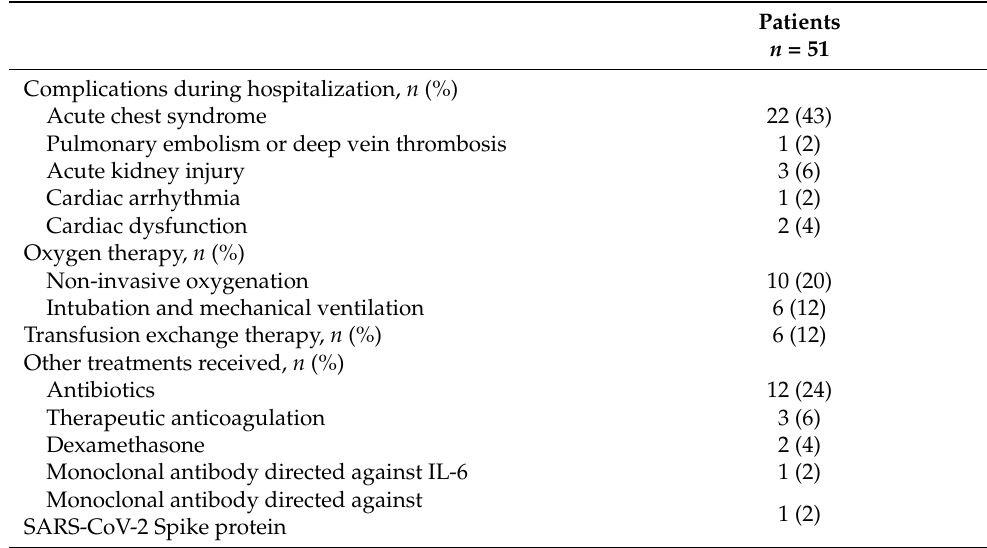
Table 3. Complications and treatment of COVID-19 in hospitalized SCD